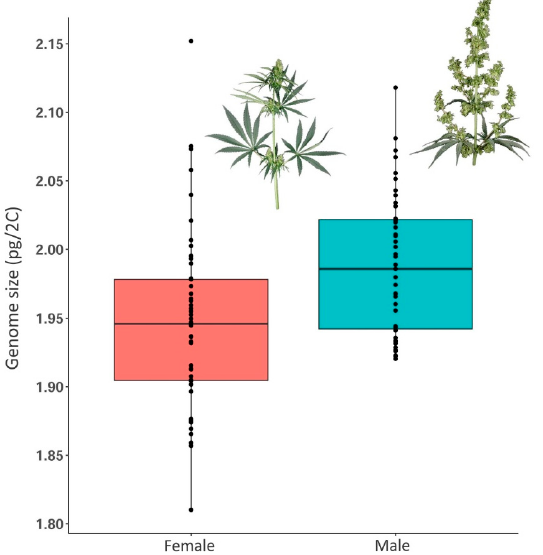
Figure 4. Boxplots showing the genome size distribution of female and male Cannabis individuals. Table 2. Differences in genome size between male and female individuals in the 15 selected Cannabis accessions. More details of the accessions can be found in the Supplementary Table (Table S1). Female Genome Size (pg/2C) Male Genome Size (pg/2C) No. ind. Mean